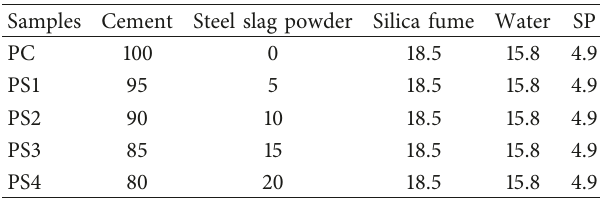
Table 4: Mix proportions of pastes (g).